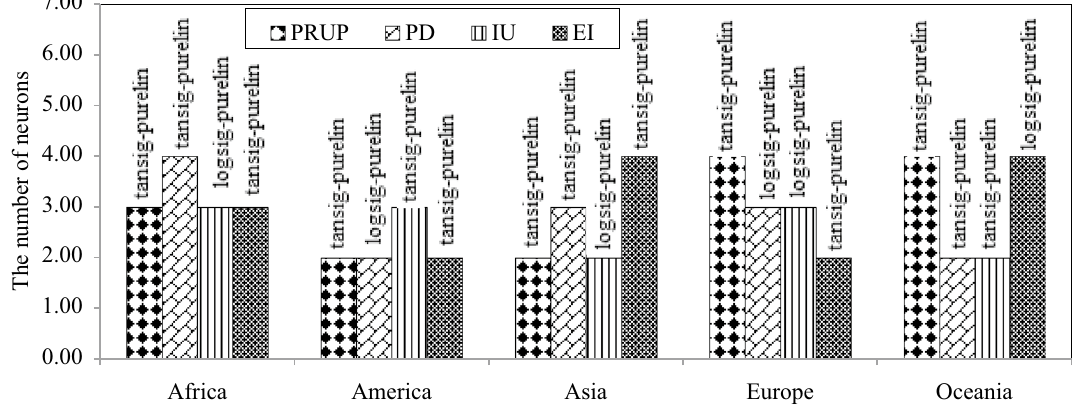
Figure 4. The characteristics of optimal ANN models; showing the number of neurons and activation functions of hidden and output layers.